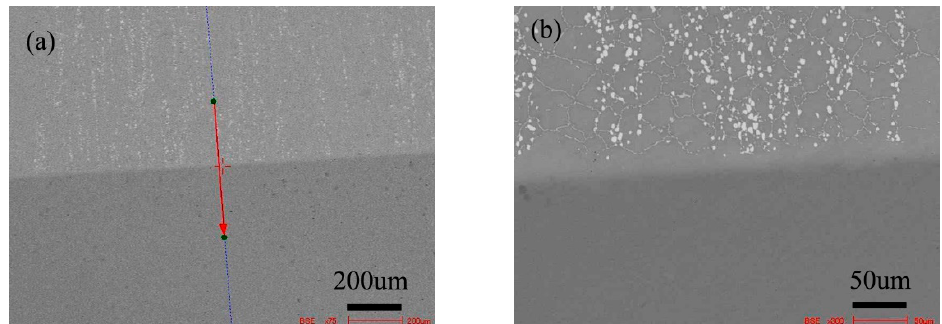
Figure 7. Composition distribution map of the diffusion couple sample of 0Si alloy and pure nickel after 800 °C/200 h heat treatment: ( a ) C, ( b ) Si, ( c ) Mo, ( d ) Cr, ( e ) Fe, and ( f ) Ni.